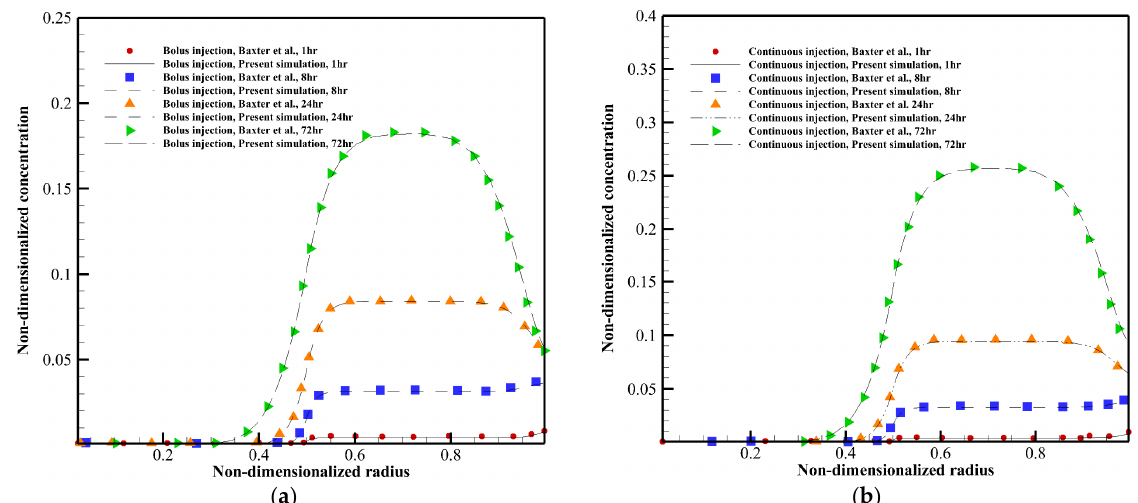
Figure 7. Comparison between the result of the present model and literature [19]. A tumor ( R = 1 cm) with a 0.5 ratio of the necrotic radius to the tumor radius is investigated in this figure. ( a ) Interstitial IgG concentration with bolus injection. ( b ) Interstitial IgG concentration with continuous injection.